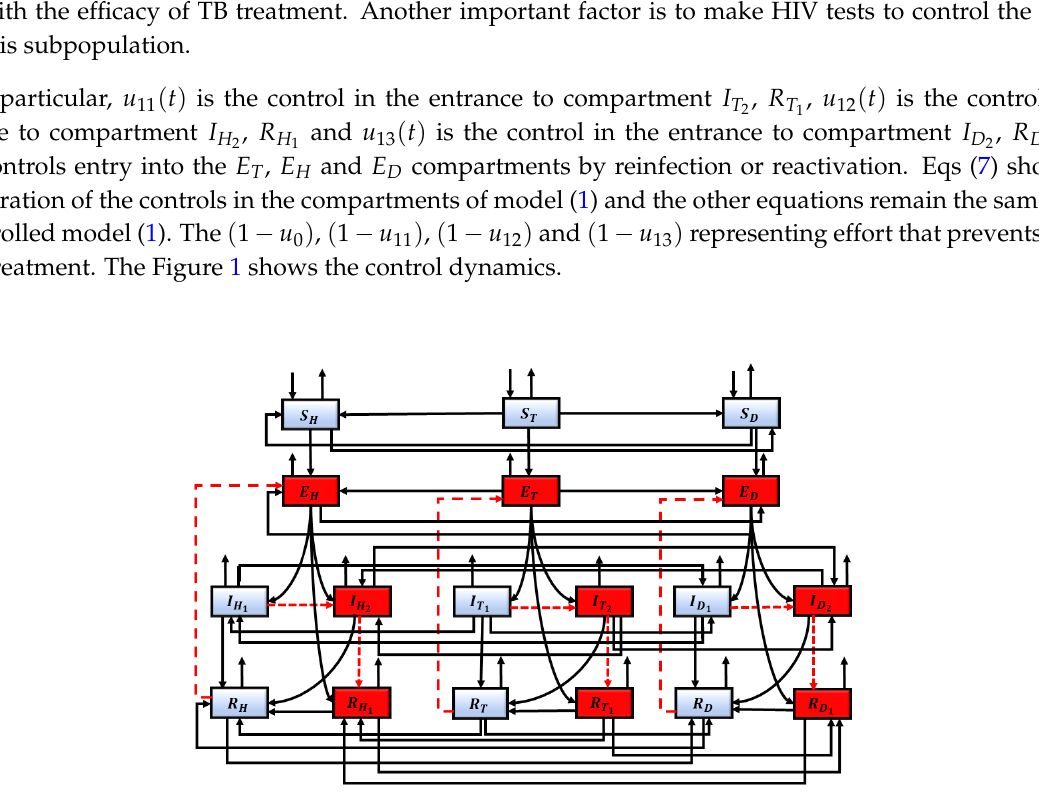
Figure 1. Schematic representation of model with controls, the arrows (discontinued) and boxes red represents the inputs and compartments to be